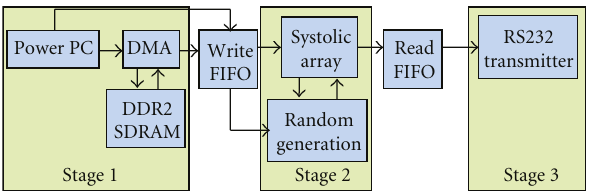
Figure 9: Our pipeline